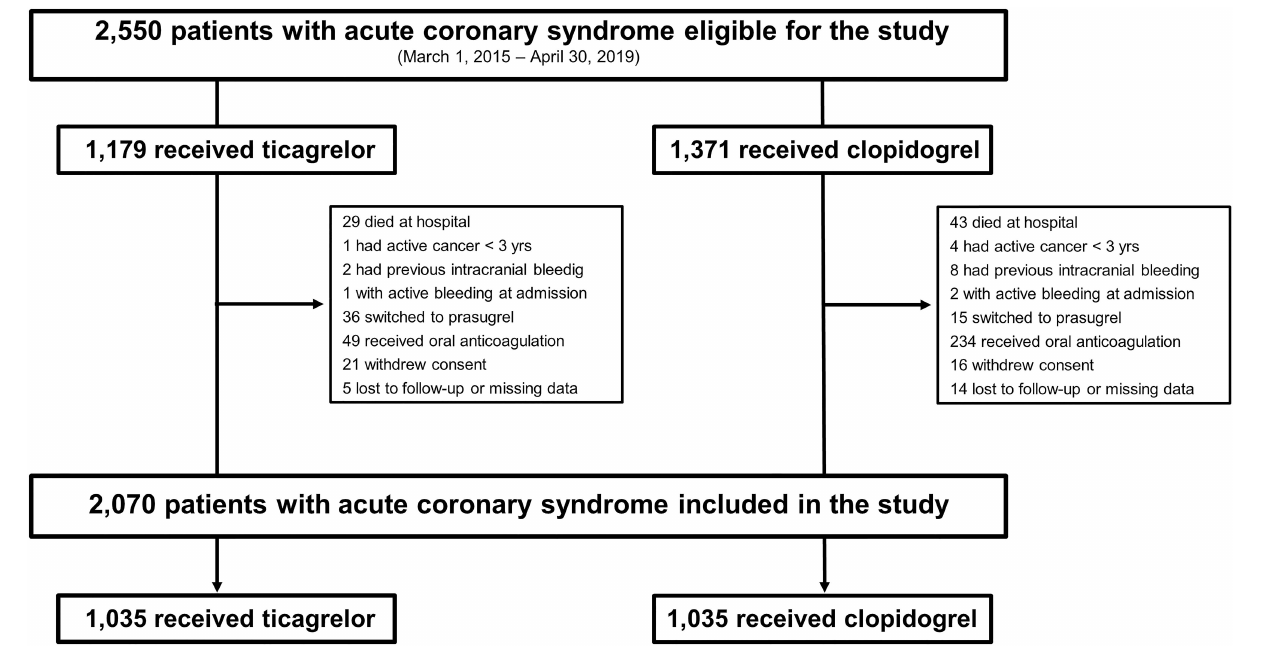
FIGURE 1 | Flow chart of